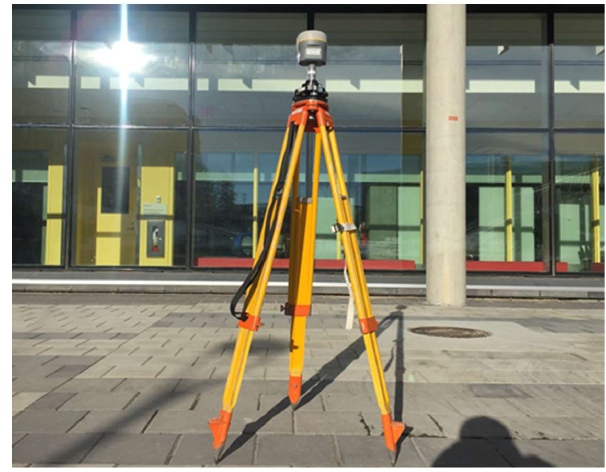
Figure 2. Observation environment of dataset no. 1 near buildings.